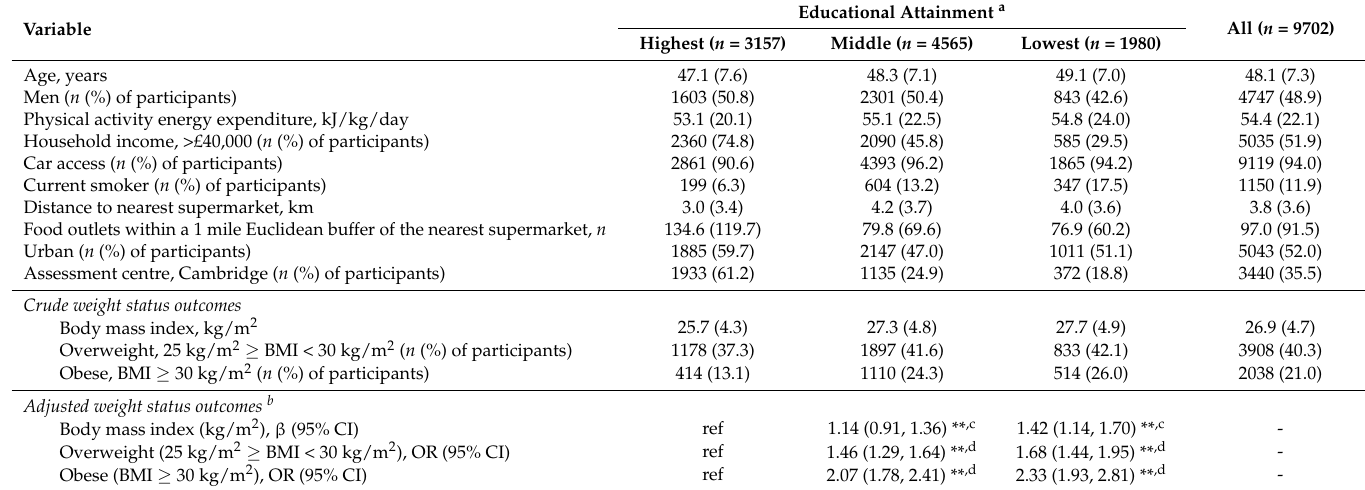
Table 1. Characteristics of participants in the Fenland Study sample, Cambridgeshire, UK, by educational attainment ( n =